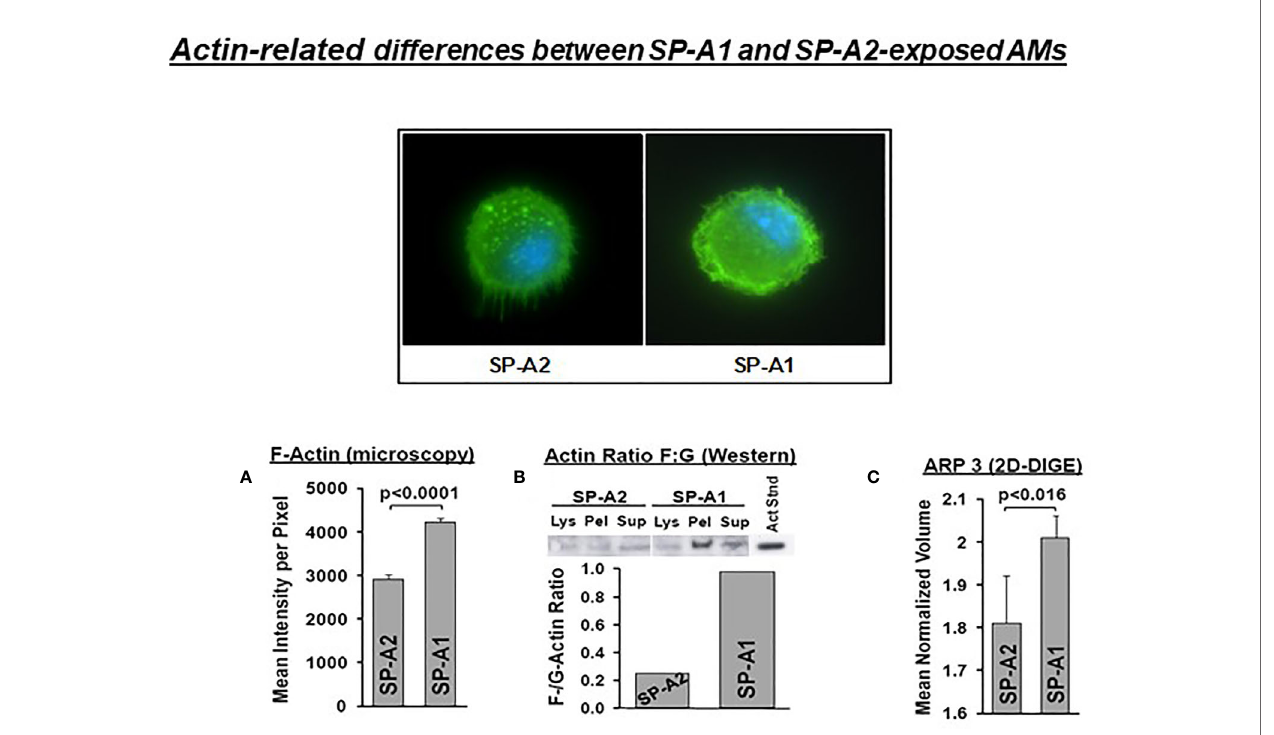
FIGURE 9 | Actin-related differences between SP-A1 and SP-A2-exposed AM (110). The pattern of fl uorescence (cells stained with AlexaFluor 488 phalloidin) of AM exposed chronically to SP-A2 or SP-A1 is shown and it is not identical. (A) depicts the mean intensity of fl uorescence per pixel and shows signi fi cant differences between SP-A2 and SP-A1 AM. (B) shows the ratio (densitometric measurements) of F-actin to G-actin in different cell fractions from a Western blot stained with an anti-actin N-terminal antibody (Sigma #2103). This ratio is lower in SP-A2 AM. (C) depicts signi fi cant differences between SP-A1 and SP-A2 in the levels of ARP3 obtained from proteomics data. Arp3 regulates actin polymerization and is part of the Arp2/3 complex, where several signaling pathways leading to actin polymerization